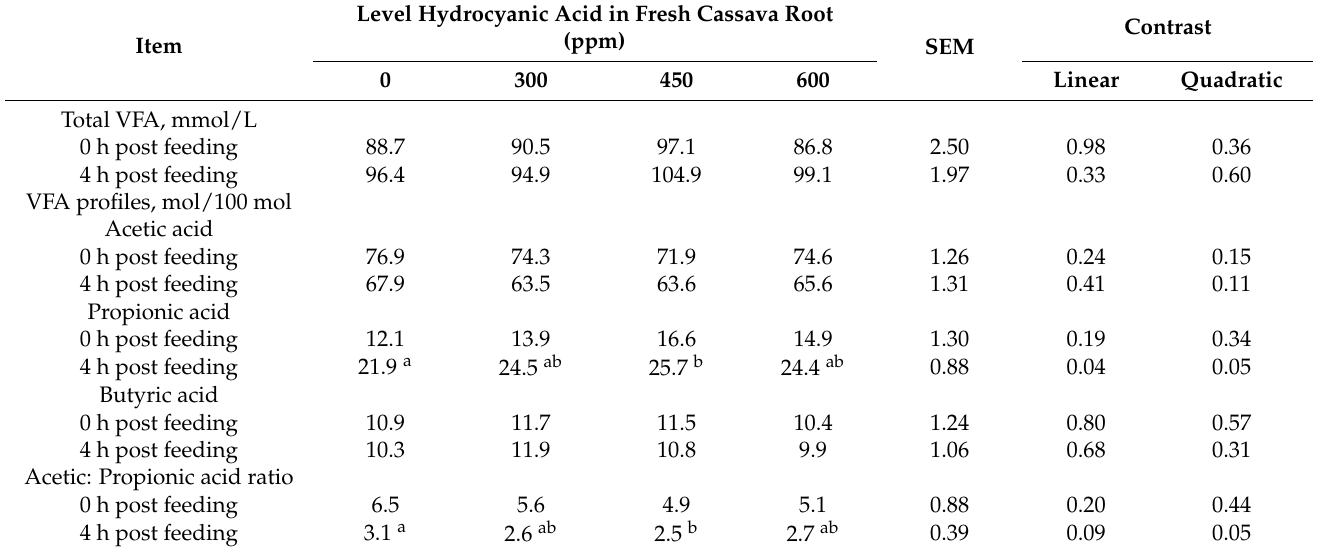
Table 4. Concentrations of total volatile fatty acid and VFA profiles of Thai native beef cattle fed with various levels of fresh cassava